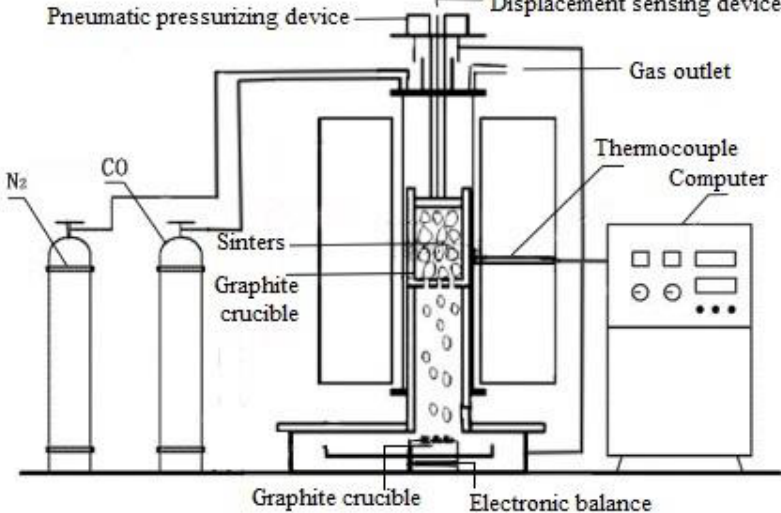
Figure 3. Schematic diagram of softening-melting-dripping tester. Table 6. Experimental conditions for softening-melting-dripping properties.